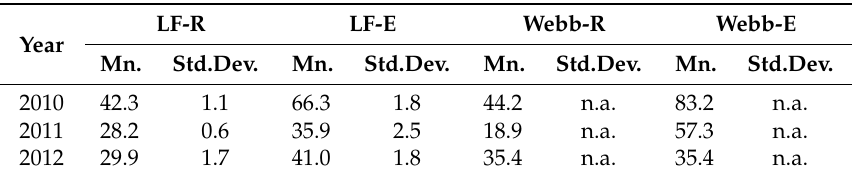
Table 5. Predicted annual TP-P loads (g · ha − 1 ) by the different groups of export flux calculation methods. Mn. = Mean, Std.Dev. = Standard Deviation within the three selected extrapolation models for each group, n.a.= not